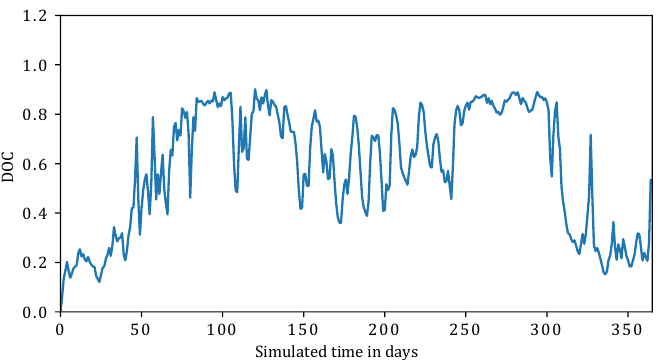
Figure 15. Demand overlap coefficient of the